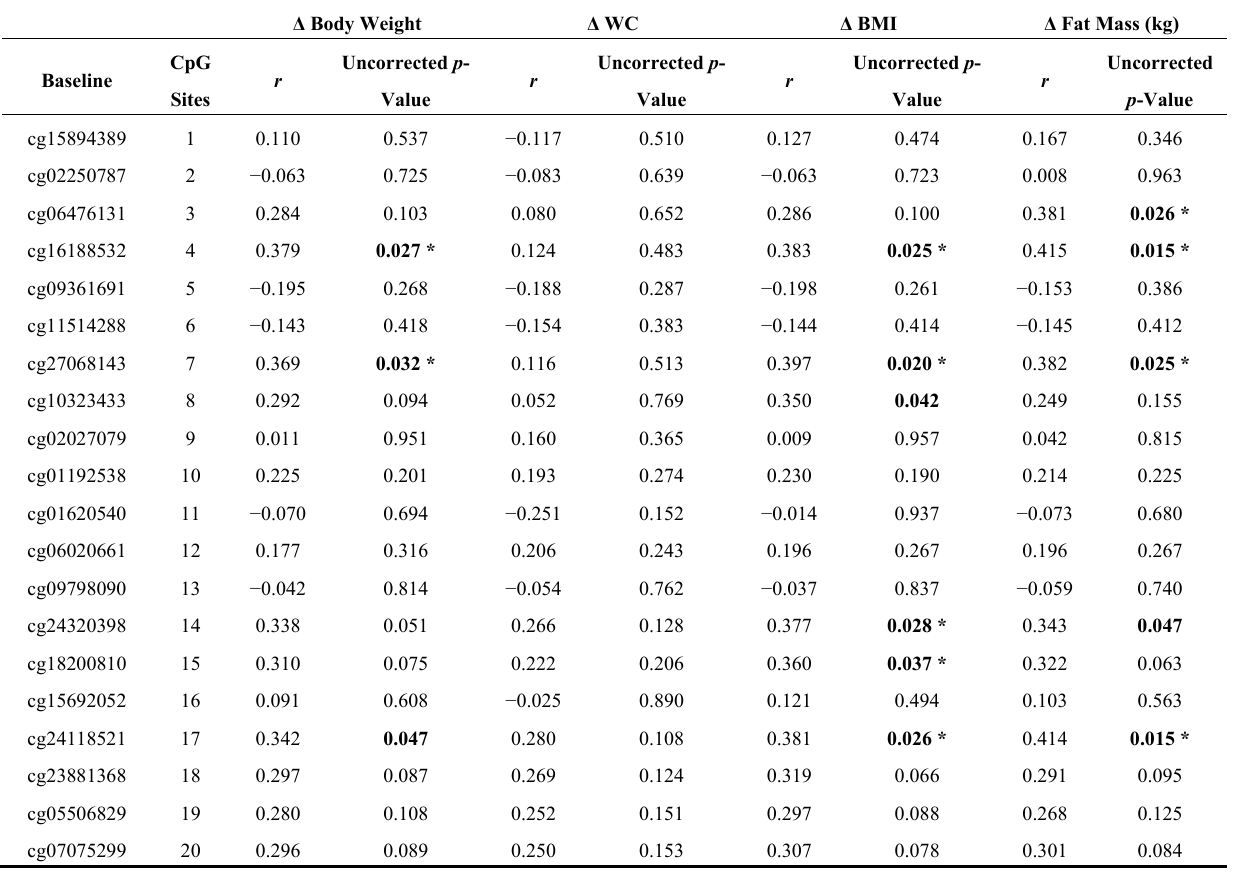
Table 3. Pearson correlation analyses between changes (six-month baseline) in body weight, BMI and fat mass with the baseline methylation (%) of HTR2A